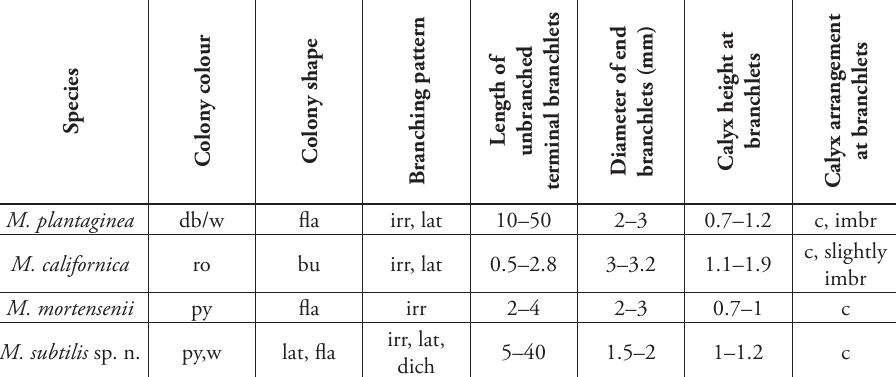
Table 2. Diagnostic characters of colony morphology in the Muricea plantaginea species-group. Measure- ments given are from holotypes and lectotypes, in mm.